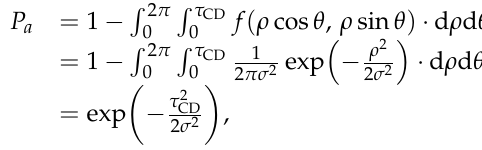
Figure 5. The trust threshold d th vs. the upper bound of replica impact ς upper given 2560, 64, 100 M m g .